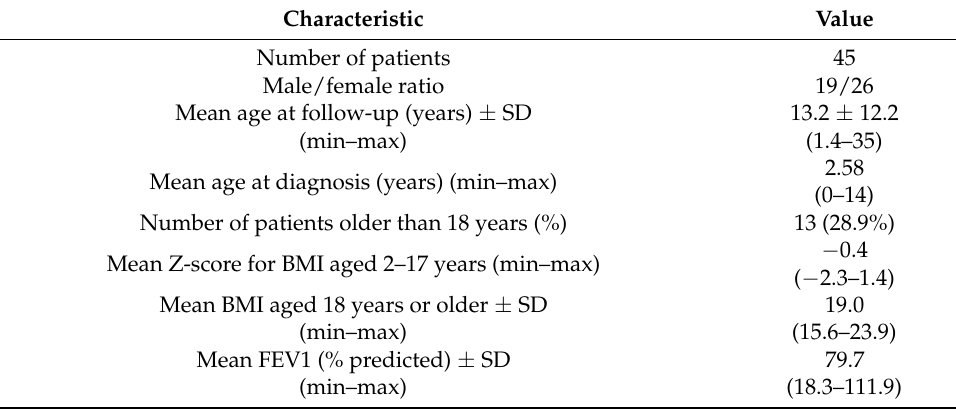
Table 3. Characterisation of CF patients currently under regular follow-up in